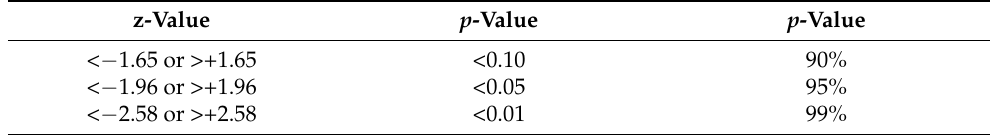
Table 10. Different standards of Moran’s I